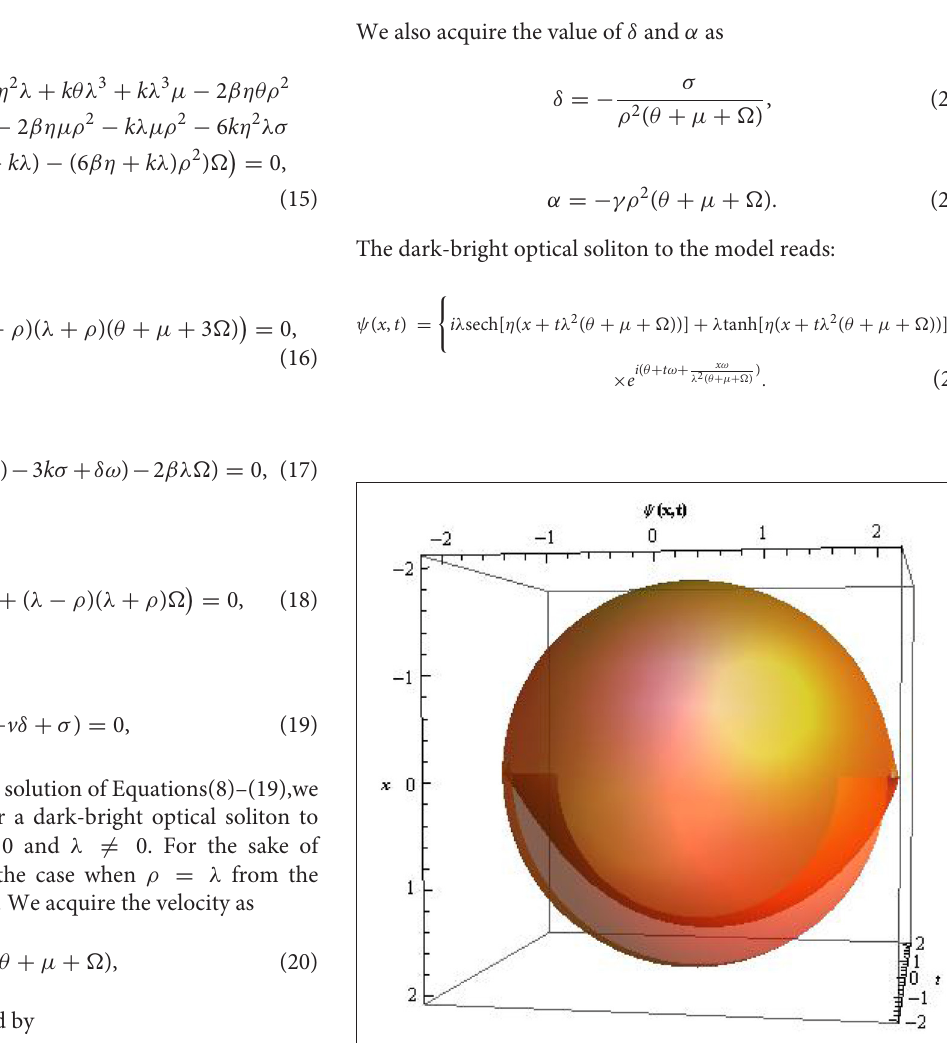
FIGURE 3 | contour plot in spherical coordinates of solution Equation (24) by selecting the parameter values of η = 0.1, λ = 0.1, θ = 1, (cid:127) = 0.1.